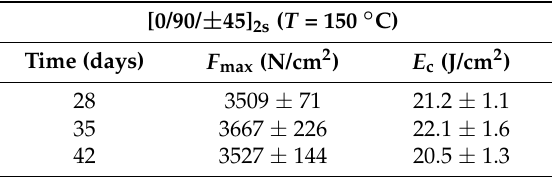
Table 5. Average maximum force and impact strength results of quasi-isotropic [0/90/ ± 45] 2s laminates subjected to an impact energy of 32.46 J after an ageing treatment at 150 ◦ C ( T < T g ). Standard deviation is included.